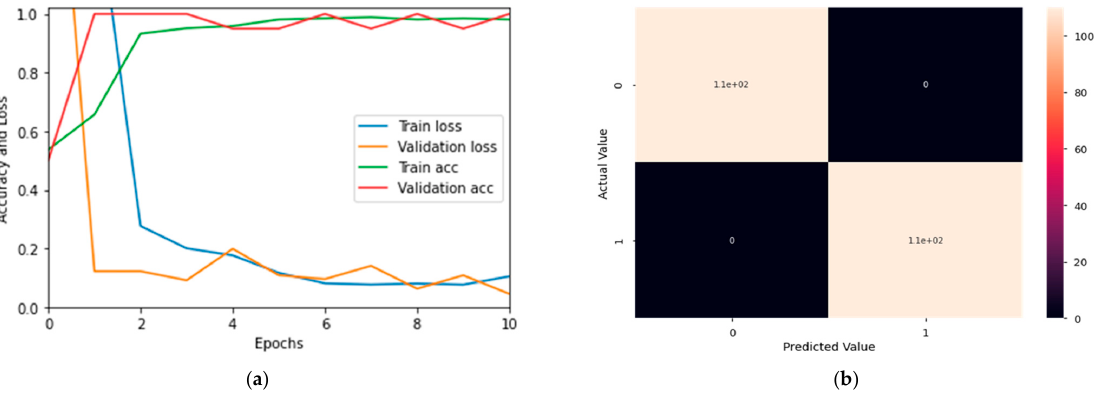
Figure 12. ( a ) A visual representation of accuracy and loss on training and validation on DiaRetDB0 and ( b ) Confusion matrix of implemented CAD-HR on DiaRetDB0.